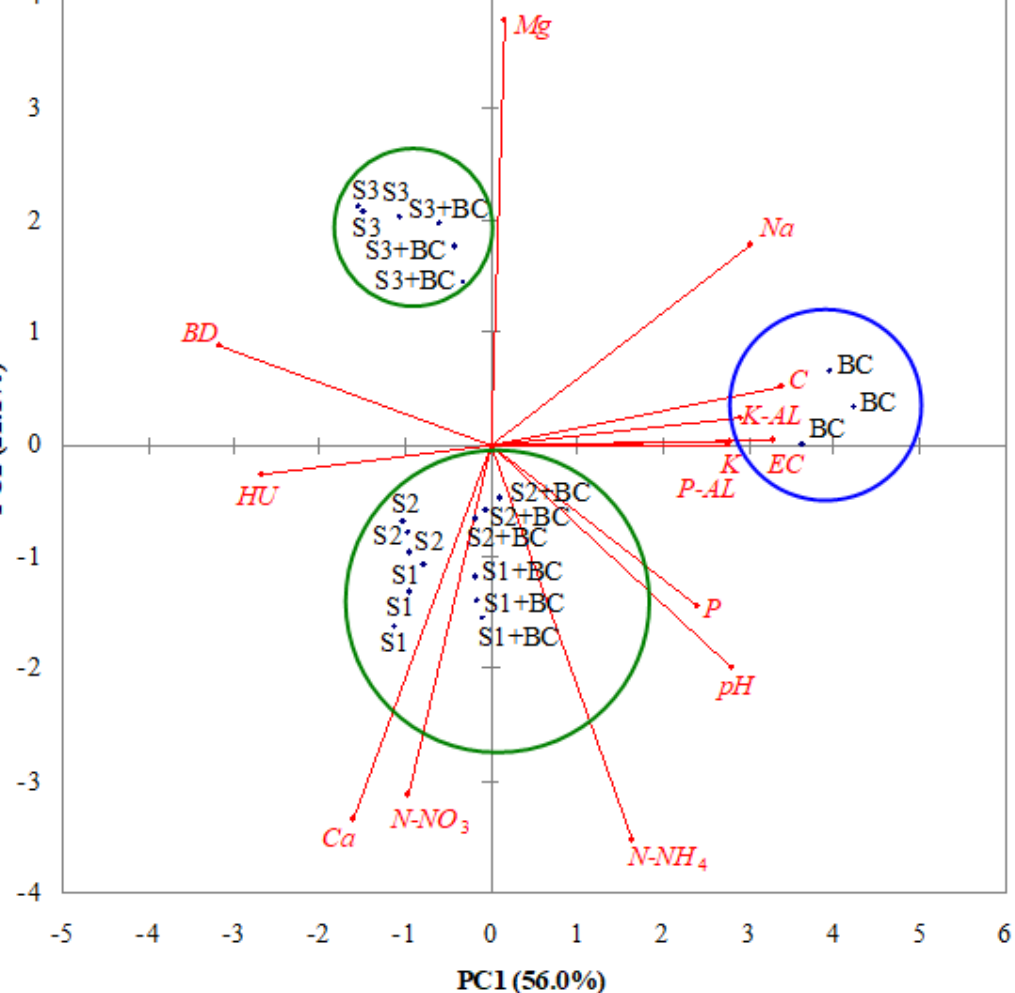
Figure 3. Projections of variables ( HU , BD , pH , EC , C , N - NO 3 , N-NH 4 , P , K , P-AL , K-AL , Ca , Mg , and Na ) and samples (S1, S2, S3, BC, S1 + BC, S2 + BC, and S3 + BC) on the factor-plane PC1–PC2: (S1) Fluvisol soil; (S2) Chernozem soil; (S3) Luvisol soil.